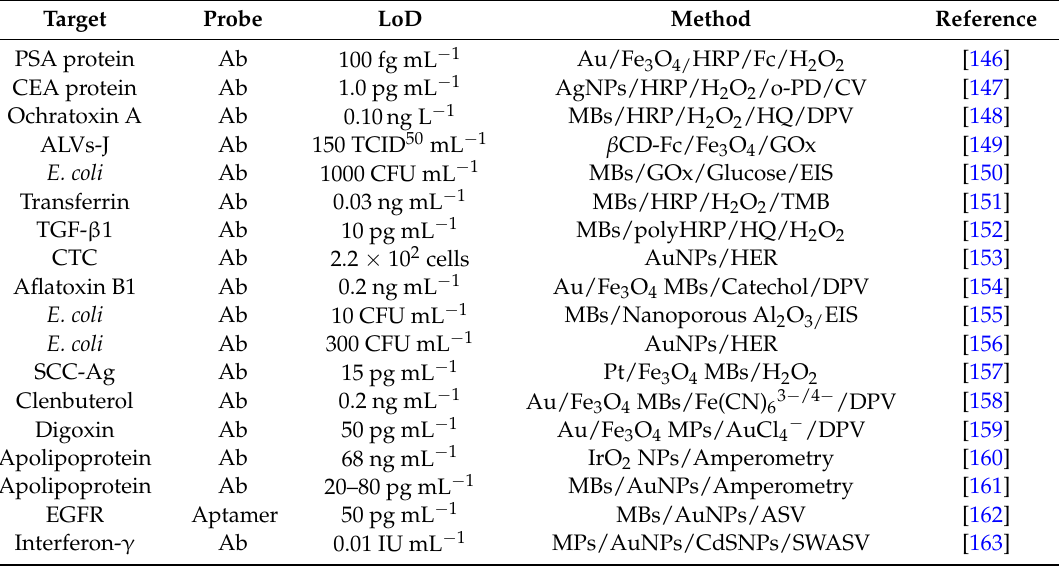
Table 9. Figures of merit of selected immunosensors using magnetic nanoparticles.